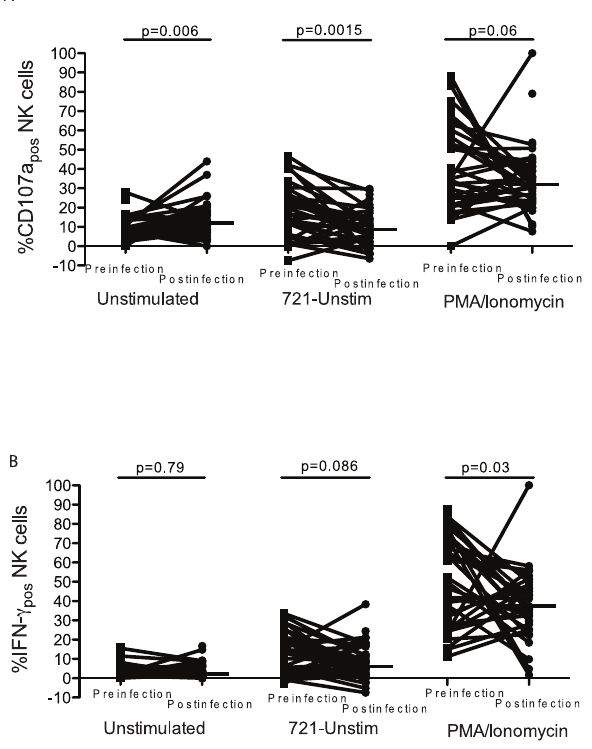
Figure 3. Following HIV infection NK-cell responses to stimulation were diminished. Natural Killer cell degranulation (A) and IFN- c secretion (B) responses after stimulation with IL-2 alone or with IL-2 and 721 cells (adjusted for background) or with PMA/ Ionomycin. Data are adjusted for background responses to media alone.